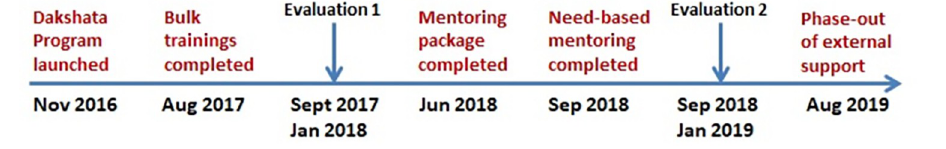
Fig 1. Status of the Dakshata program implementation, and evaluation in Andhra Pradesh between 2016 and